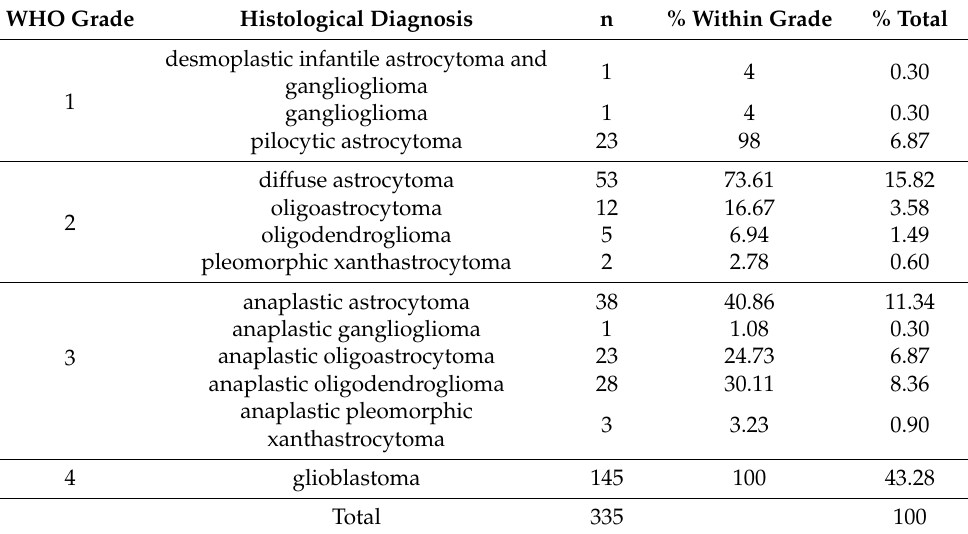
Table 1. Distribution of histological diagnosis within glial tumor grades. WHO